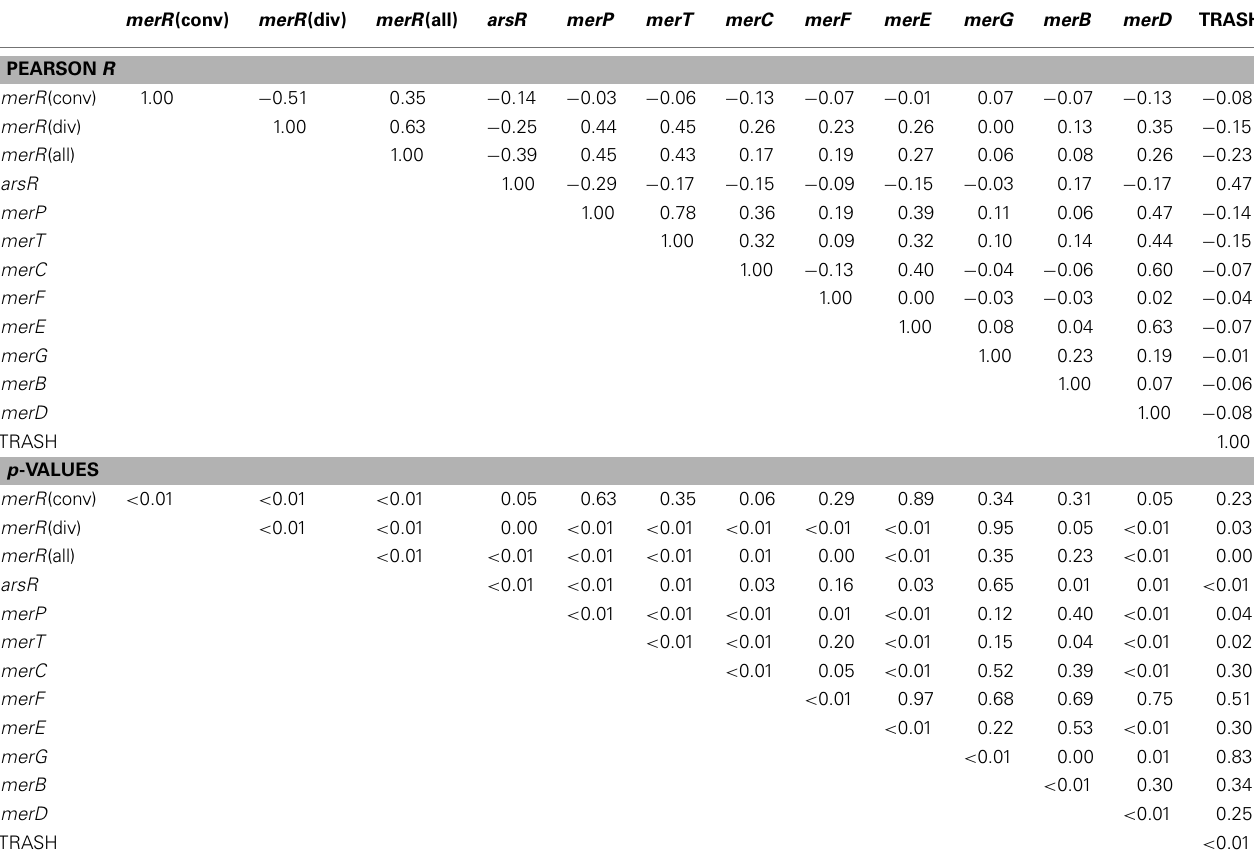
Only mer operons that were encoded on a chromosome were considered. An analogous analysis with all mer operons included is presented in Table S2 in Supplementary